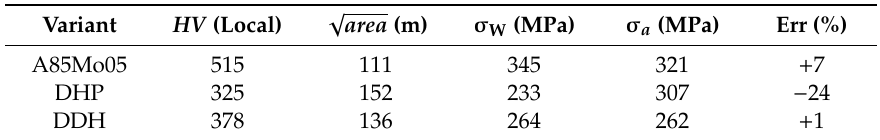
Table 7. Fatigue strength estimated with the Murakami model considering the microhardness of the softest microstructural constituent. Table taken from [26]. √ Variant HV (Local) area (m) σ W (MPa) σ a (MPa) Err (%) A85Mo05 515 111 345 321 + 7 325 152 233